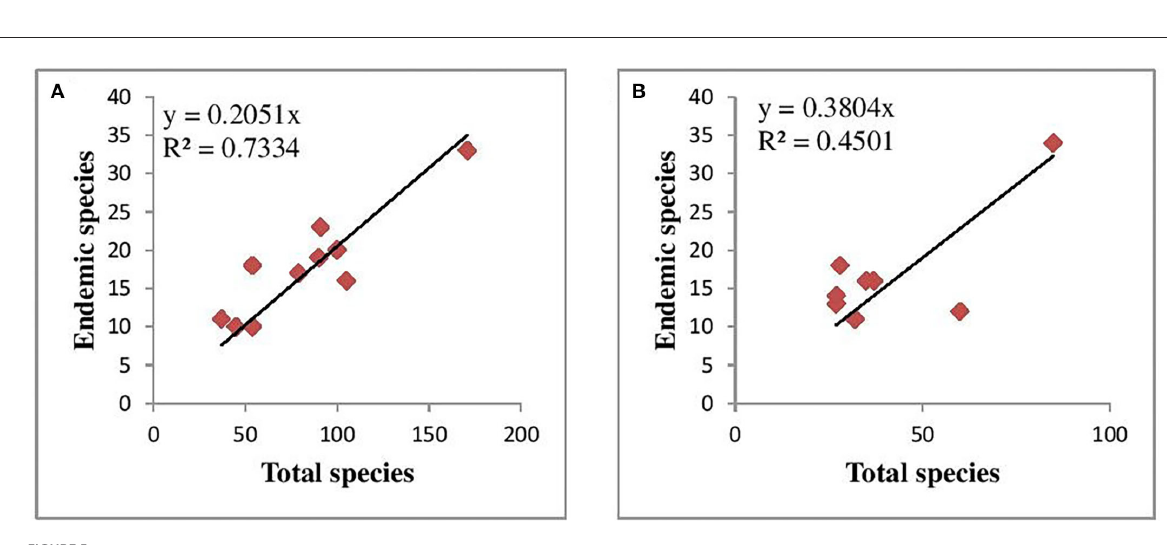
FIGURE5 Correlation between total species and endemic specie (A) forest zone (B) alpine